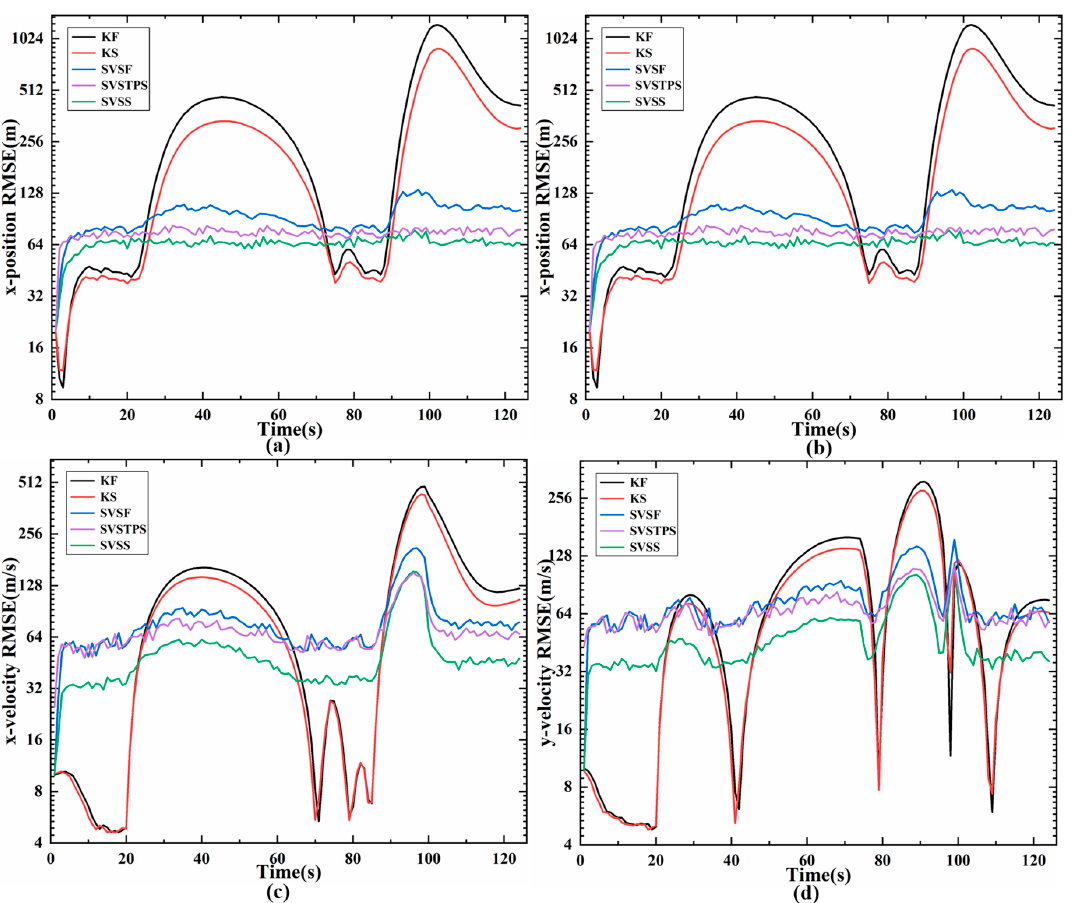
Figure 9. RMSE of state estimation (m) ( a ) position RMSE on x- axis; ( b ) position RMSE on y-axis; ( c ) velocity RMSE on x- axis; ( d ) velocity RMSE on y-axis.